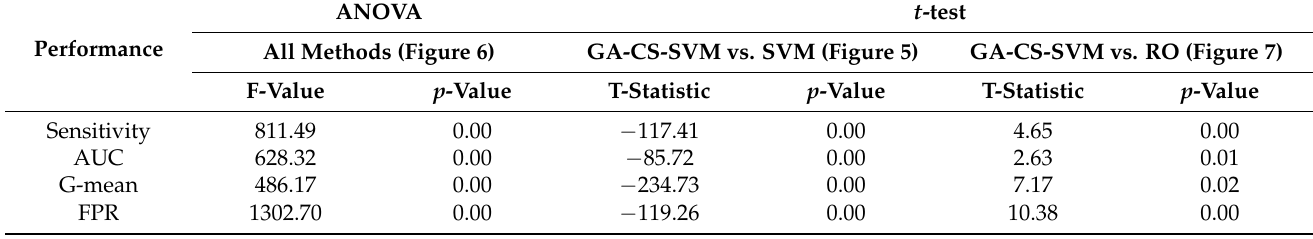
Table 4. Statistical tests performed on phase 1.